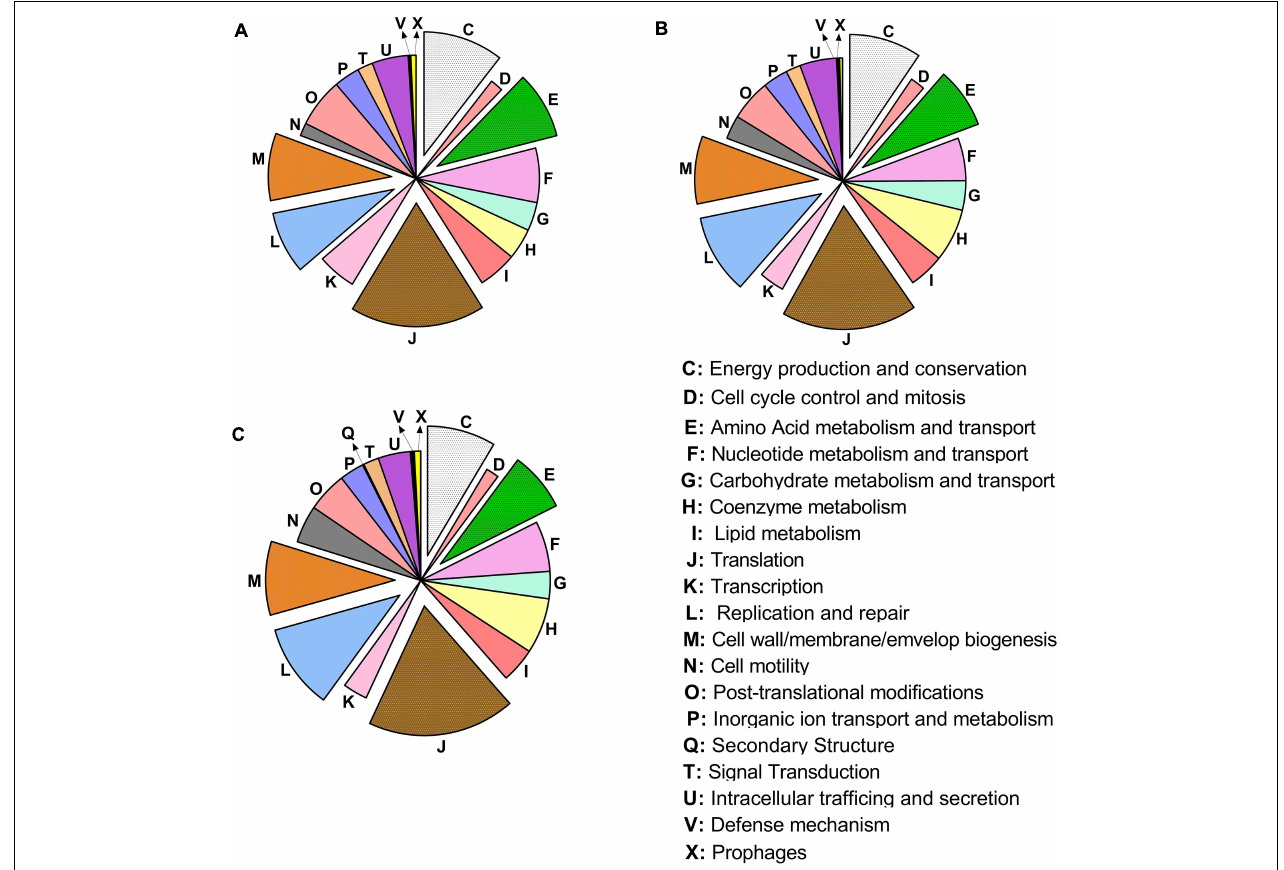
FIGURE 3 | Distribution of the cluster of ortholog groups in “ Candidatus Liberibacter asiaticus” (reference strain JXGC, NZ_CP019958.1), measured as mapped reads in Diaphorina citri gut after acquisition access periods of 1/2 days (Las I) (A) , 3/4 days (Las II) (B) or 5/6 days (Las III) (C)